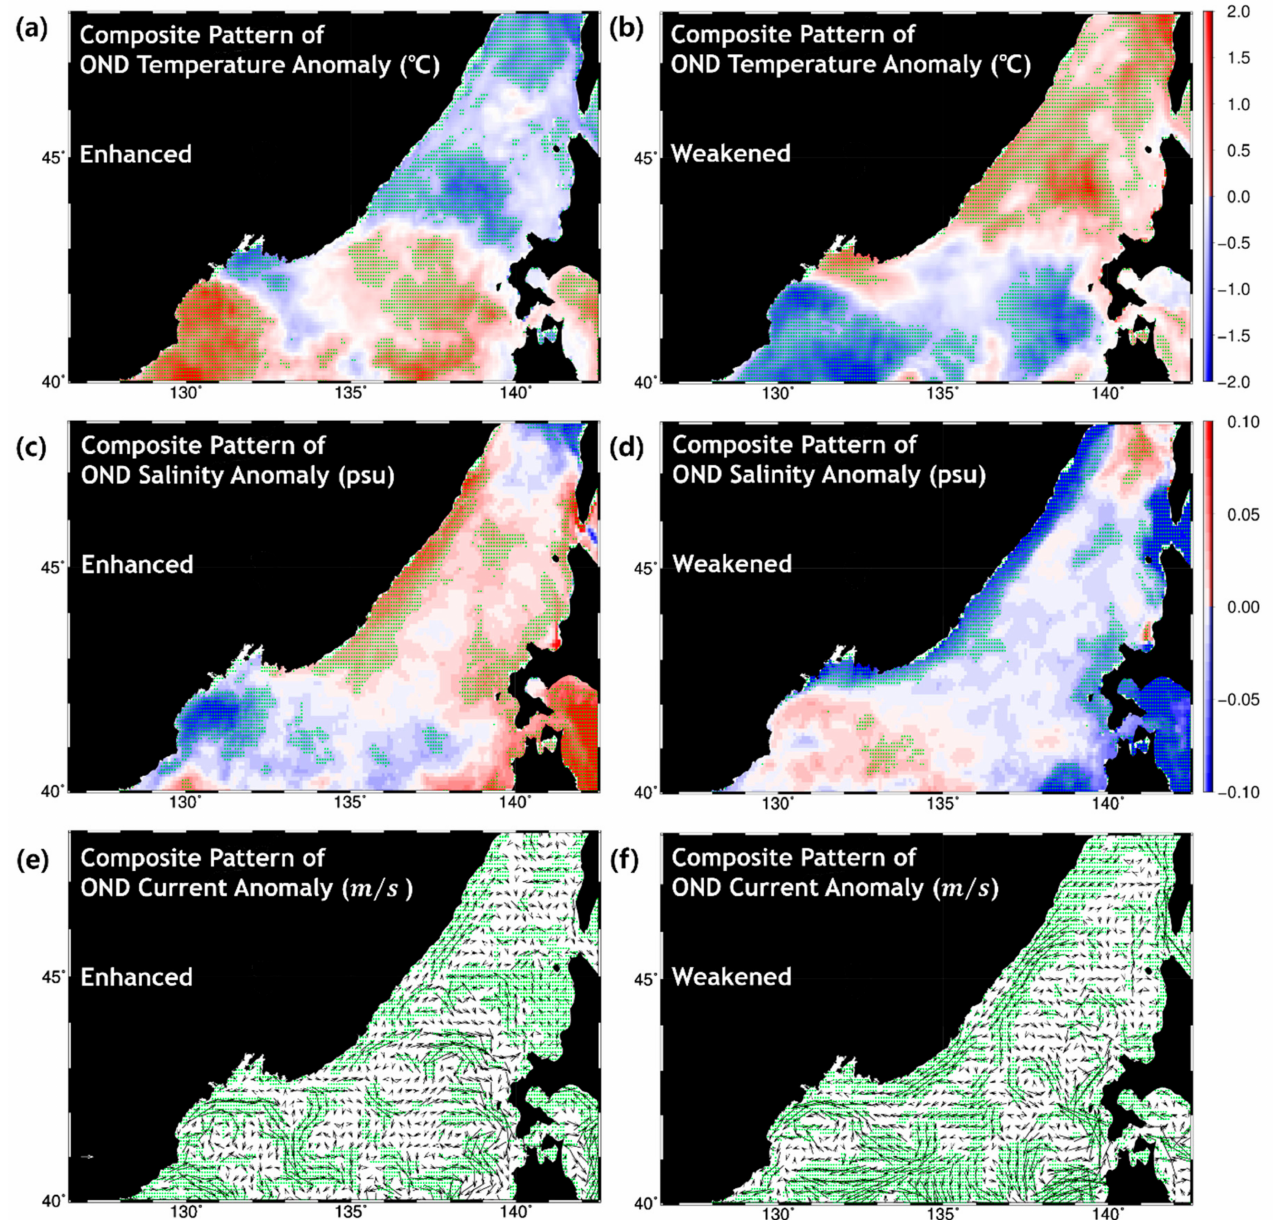
Figure 6. Horizontal distribution of the average anomalous ( a , b ) temperature, ( c , d ) salinity, and ( e ,f) current at 20 m depth calculated using HYCOM reanalysis data for ( a , c , e ) enhanced and ( b , d , f ) weakened mesoscale activities in the NES. For the composite anomalies, a two-tailed student t-test using the Monte Carlo procedure is utilized to test the significance of anomalies at the 95% confidence level, as displayed by the green